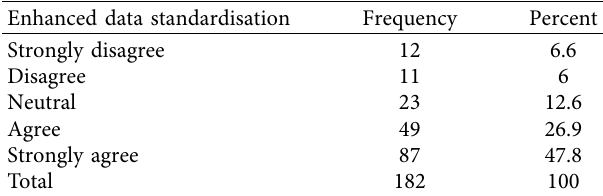
Table 2: enhanced data